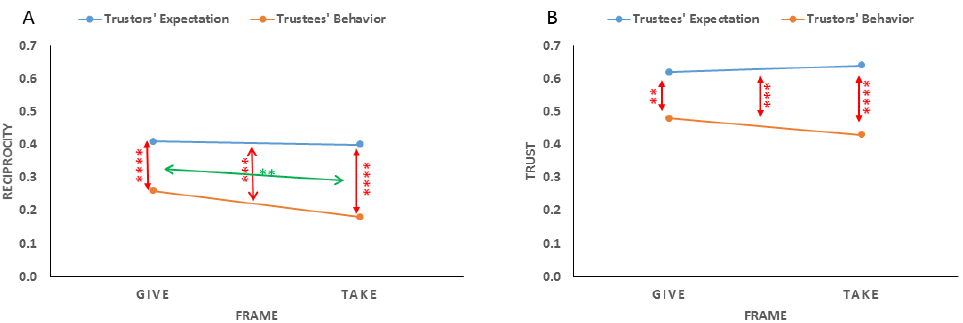
Figure 3. Player’s expectations regarding partners’ real behavior for trust and reciprocity. ( A ). Trustors. Trustors expected higher reciprocity than their partners’ real reciprocity under both frames (Give [G], Take [T]). A framing effect was observed with a lower incongruency (Expectation, Reality) in the G- than T-Frame—being more evident in the T- than G-Frame. ( B ). Trustees. Trustees expected higher reciprocity than their partners’ real trust under both frames (G, T). ** p < 0.01, *** p < 0.005,